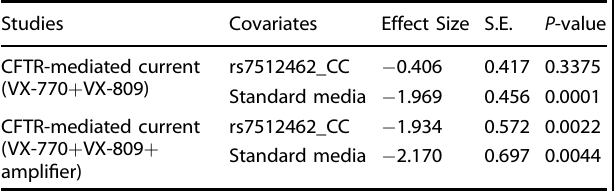
Table 4. Association of rs7512462 with change in function to modulator